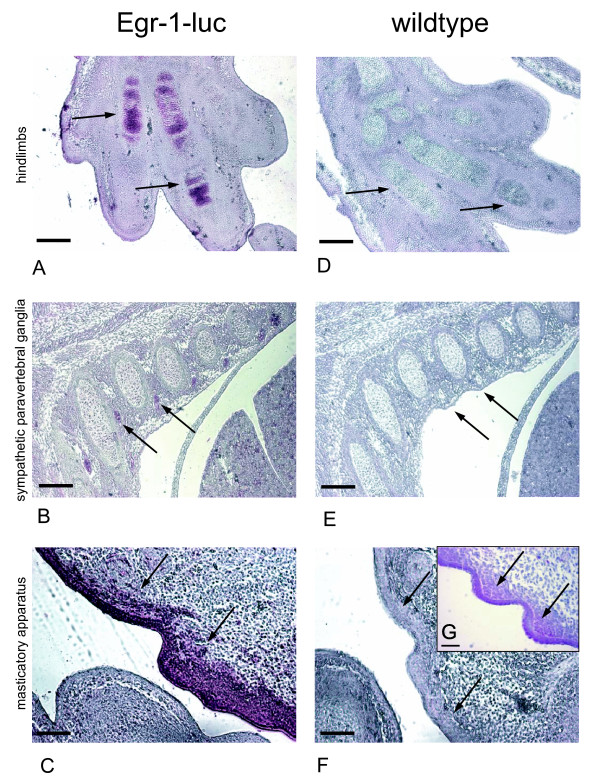
Immunohistochemical analyses of luciferase and Egr-1 expression during embryonic development. Egr-1-luc (A, B, C and G) and wildtype (D, E and F) C57BL/6 embryos on day E14 of development were stained for luciferase protein (A-F) or Egr-1 protein (G). In bone primordia of hindlimbs (A), sympathetic paravertebral ganglia (B) and masticatory apparatus (C) luciferase positive areas (arrows) are stained in lilac in transgenic embryos, in wildtype embryos no luciferase signal was detected (D-F). When staining for Egr-1 protein, a similar pattern of protein expression was found - exemplarily shown for the masticatory apparatus (G) - as for luciferase (C); scale bar: 50 μm